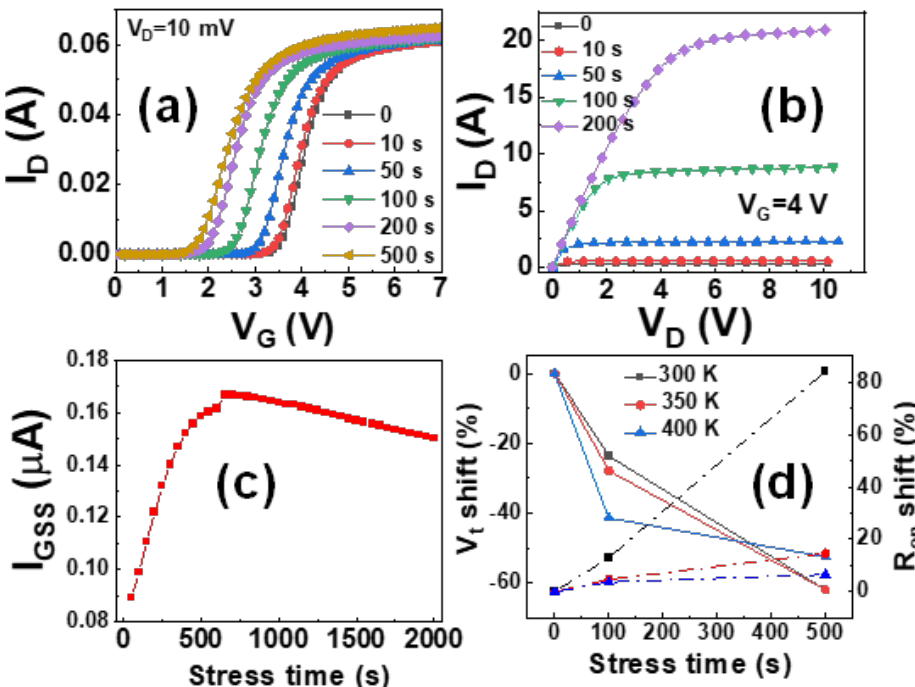
Figure 3. ( a ) I D -V G and ( b ) I D -V D curves obtained after different gate stress time. ( c ) Variation of I GSS with stress time. ( d ) Shift of V t and on-state resistance as a function of stress time at different temperatures (300 K, 350 K, and 400 K).